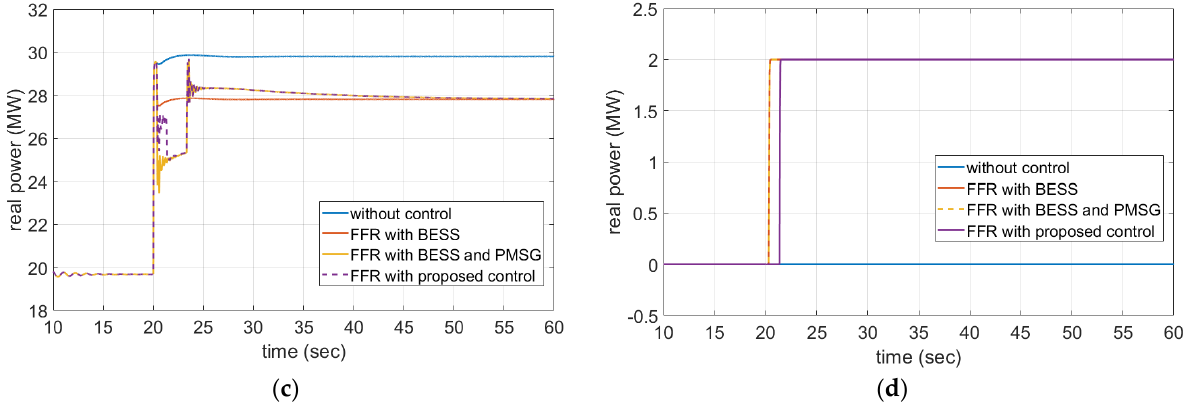
Figure 11. Simulation results: ( a ) system frequency; ( b ) output power of the PMSG type wind turbine; ( c ) output power of